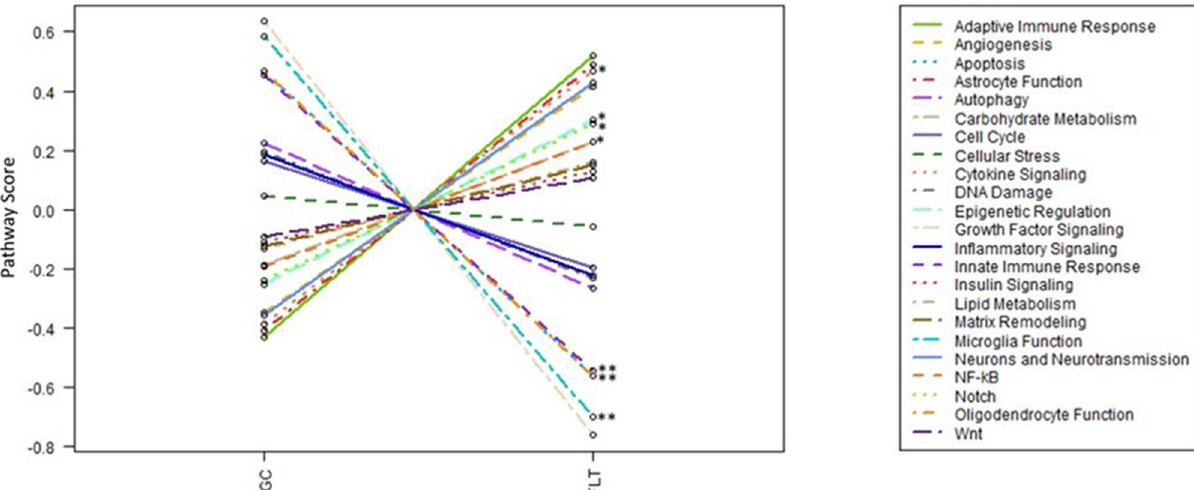
Fig. 5 Space fl ight-induced changes of pathway scores. Summarized pathway scores in fl ight (FLT) group vs. ground control (GC). *Signi fi cantly upregulated pathways ( p < 0.05), include: